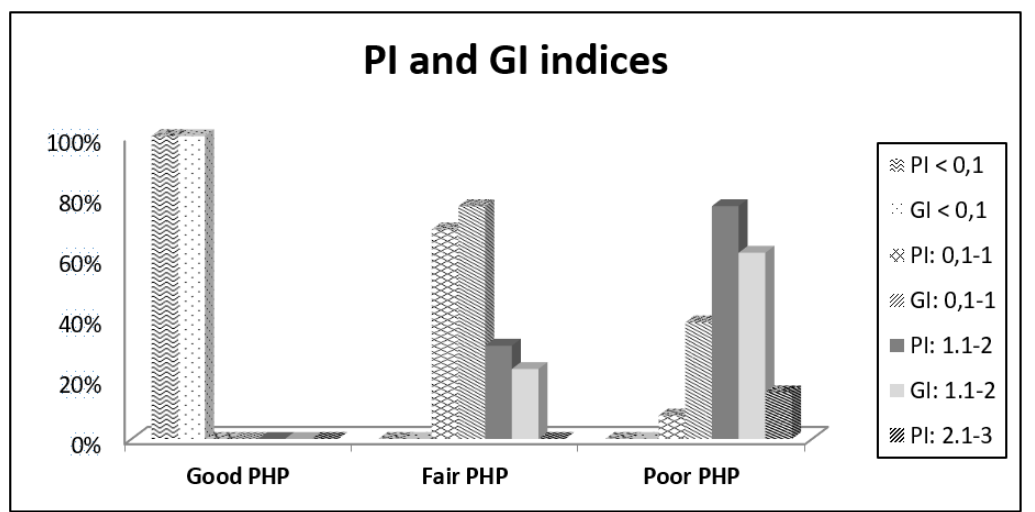
Figure 1. Descriptive statistics (% of gingival index (GI) and plaque index (PI))